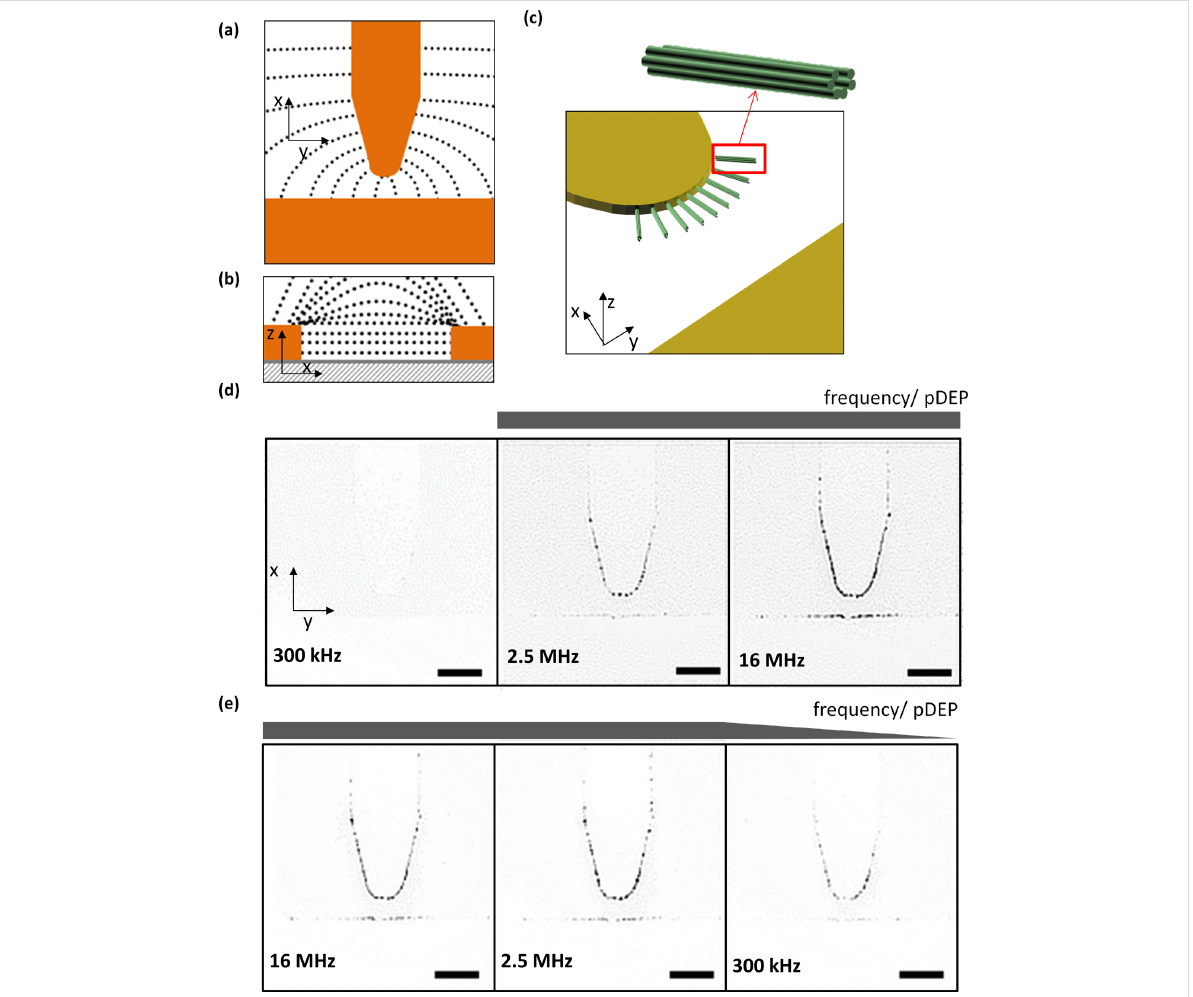
Figure 3: Dielectrophoretic manipulation of six-helix bundles. Schematic representation of the (a) top and (b) side view of the field line gradient, and (c) the six-helix bundle trapping by positive DEP. Potential is applied along the x-axis. Inverted fluorescence microscopy images of the measurement series taken at 1·10 6 V/m with a stepwise (d) increasing or (e) decreasing frequency. The scale bar is 25 μ m.